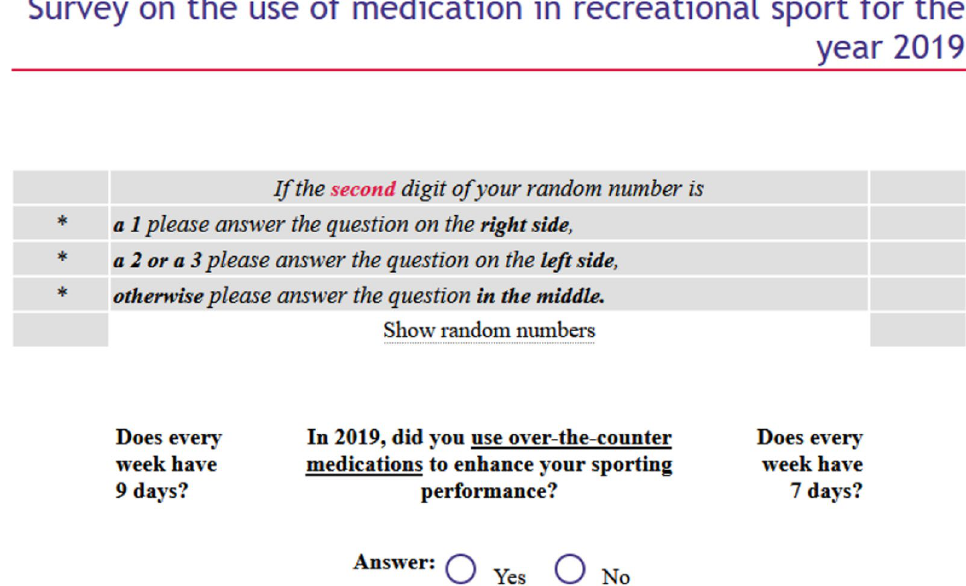
Fig. 2 Example of an RRT question from the